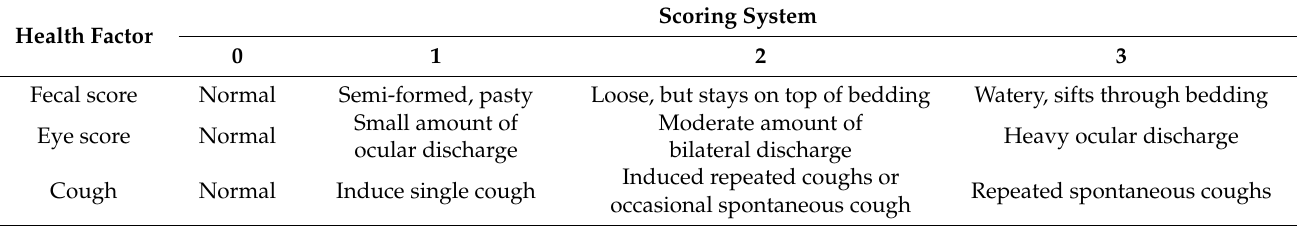
Table 2. Calf health scoring